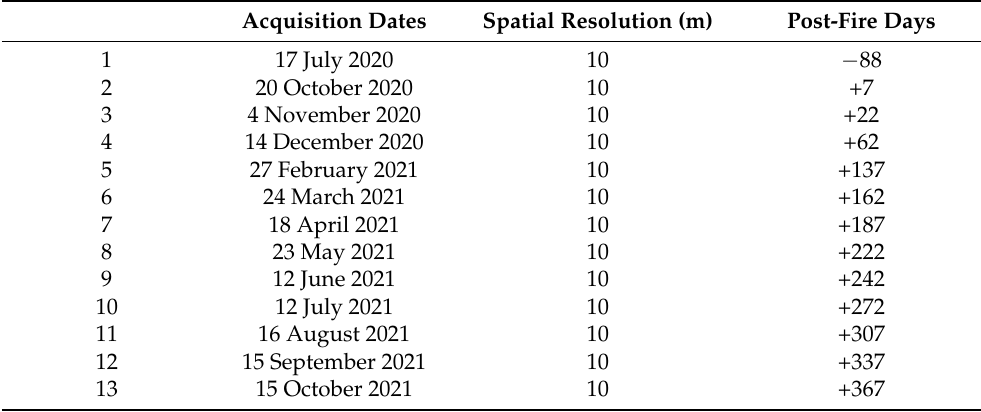
Table 1. The time-series Sentinel-2 image data used in this study.